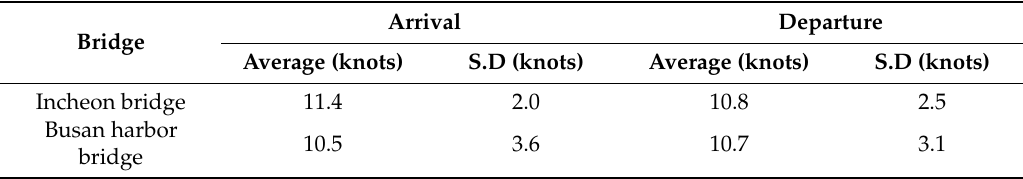
Table 7. Sailing speeds passing through the target